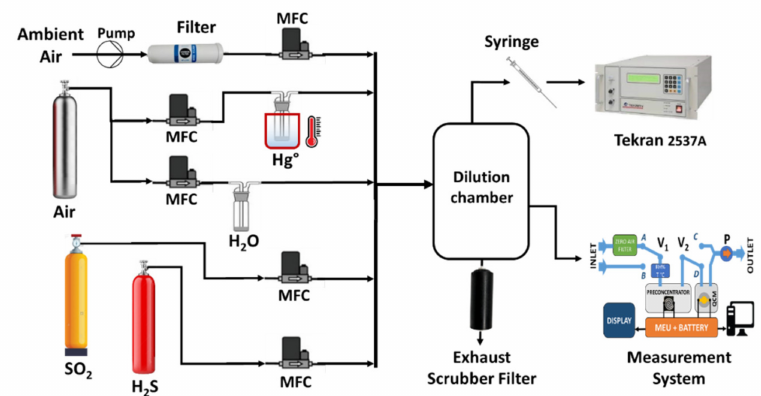
Figure 7. Depiction of the measurement setup and the instrumental system.